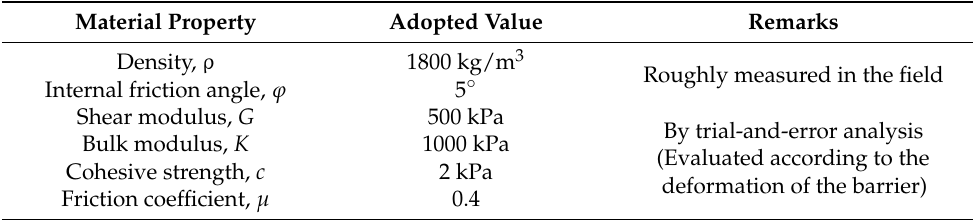
Table 1. Key parameters adopted to simulate the landslide mass.